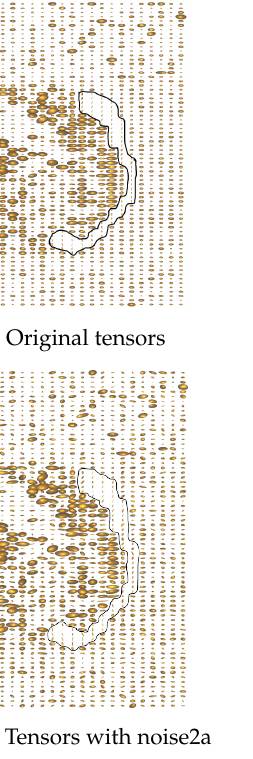
Figure 1. The original tensors in comparison with the tensors having added the three levels of noise.